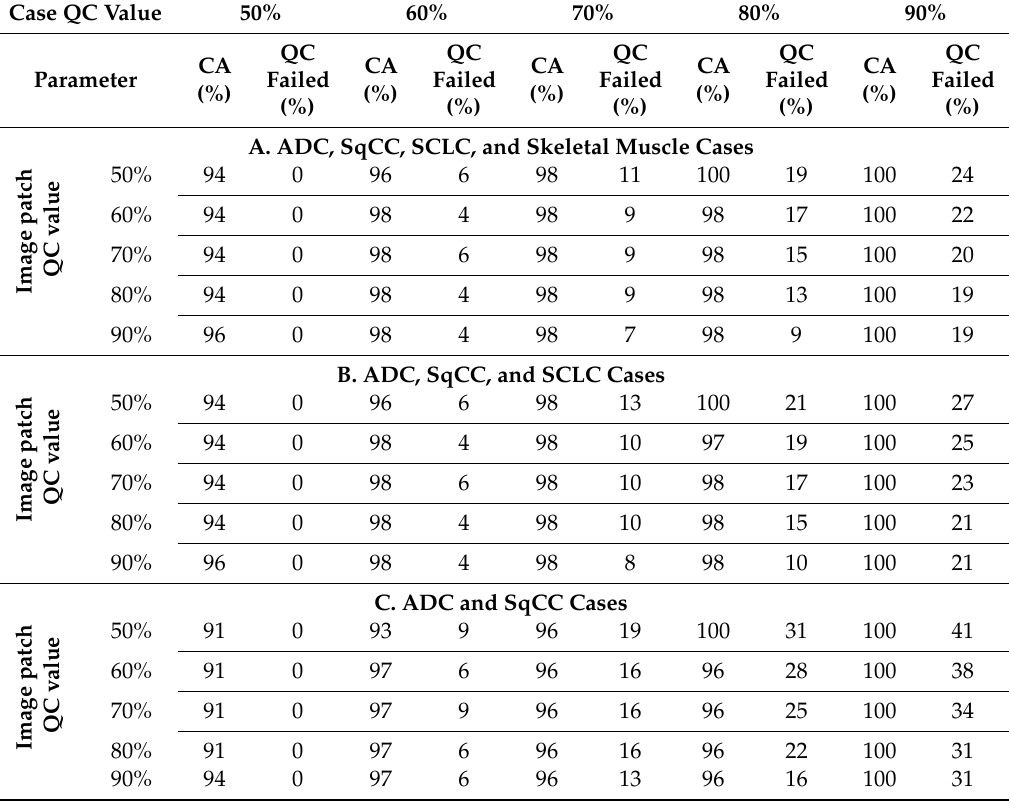
Table 4. Classification accuracy and proportion of cases in which QC